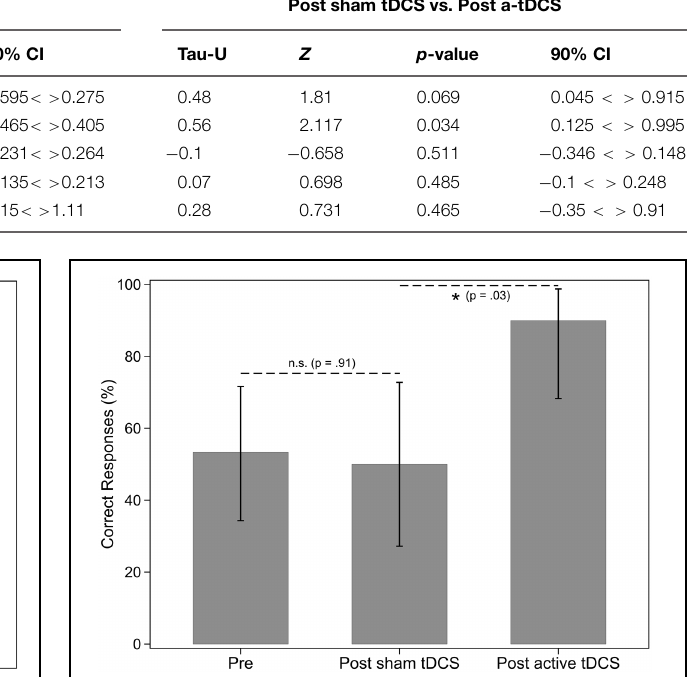
TABLE 4 | Inferential statistics (Tau-U).